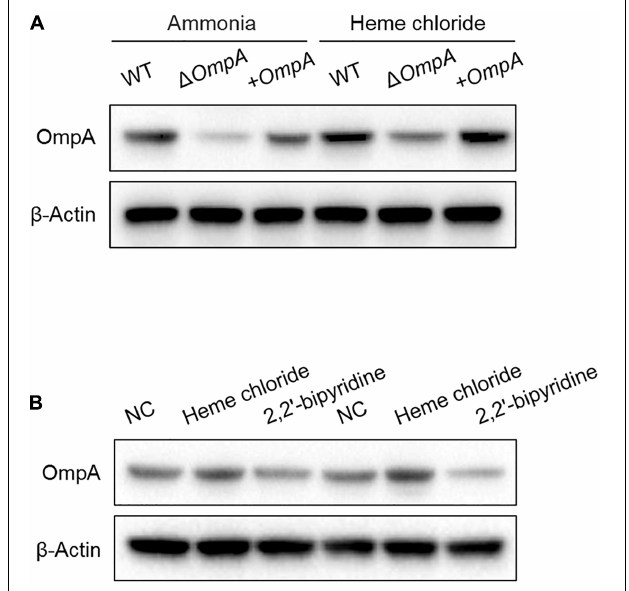
FIGURE 1 | (A) Western blot analysis of the changes in OmpA protein expressions after treatment with hemin solution. (B) Detection of the effect of iron ion content on the OmpA expression. Two experiments were conducted with wild-type strains. A. baumannii standard strain ATCC17978). The A. baumannii wild-type strain was 5 × 10 7 CFU/mL